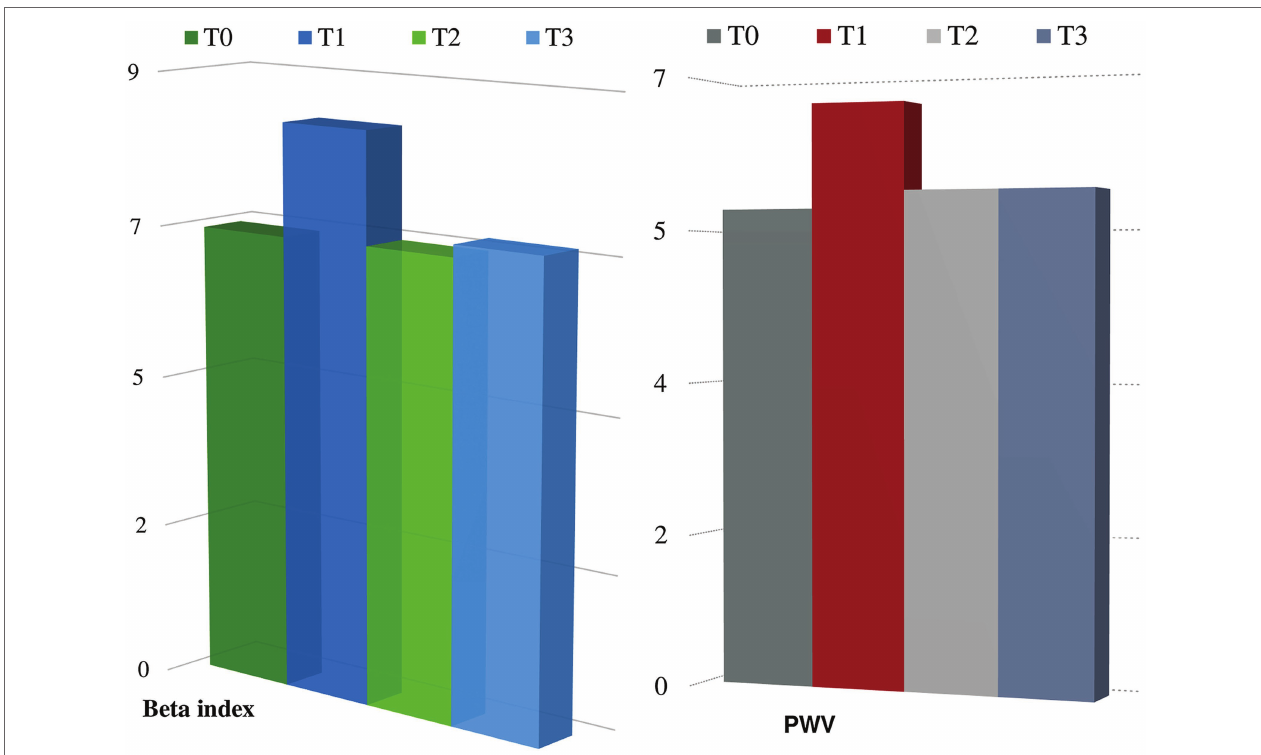
FIGURE 1 | Changes in arterial stiffness parameters during follow-up. p < 0.05 at T1 compared to T0 either for PWV and beta index.